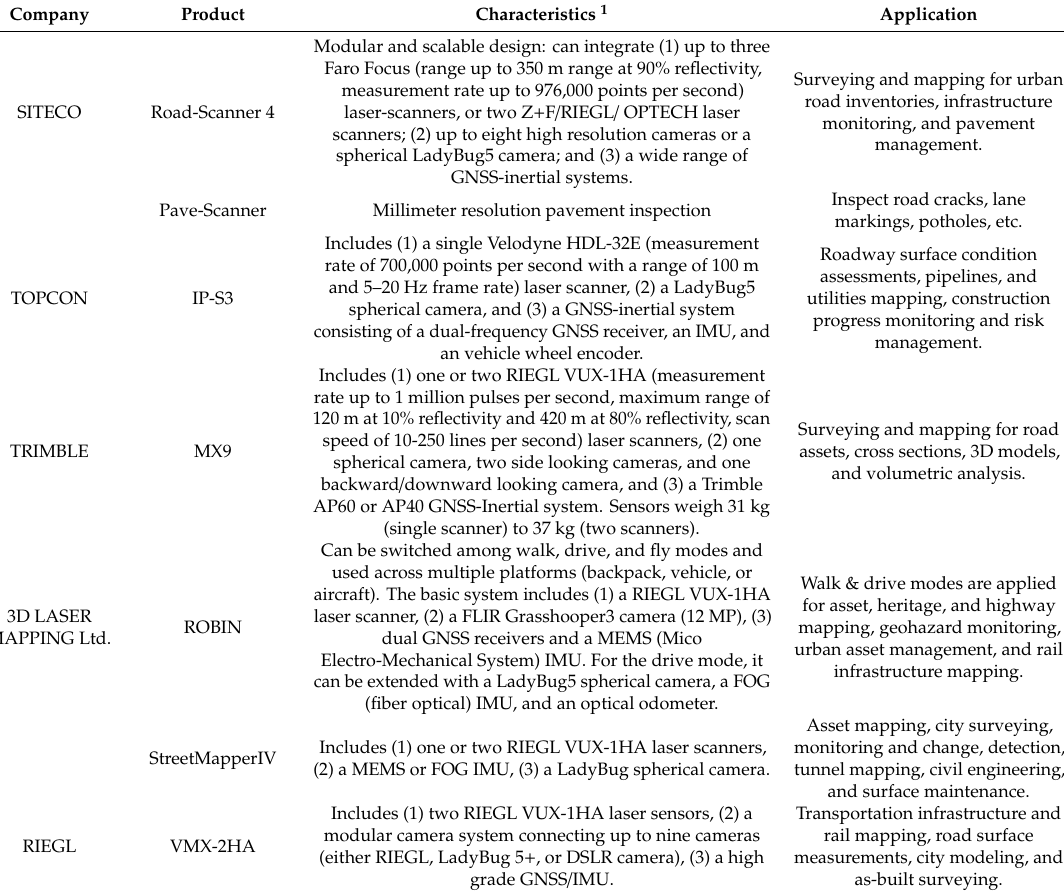
Table 1. Summary of some of the latest mobile mapping